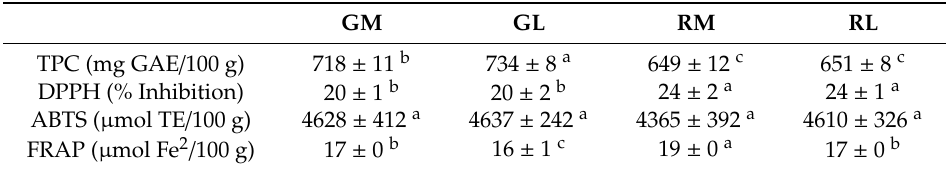
Table 3. The antioxidant properties of the cactus pear residue tablet